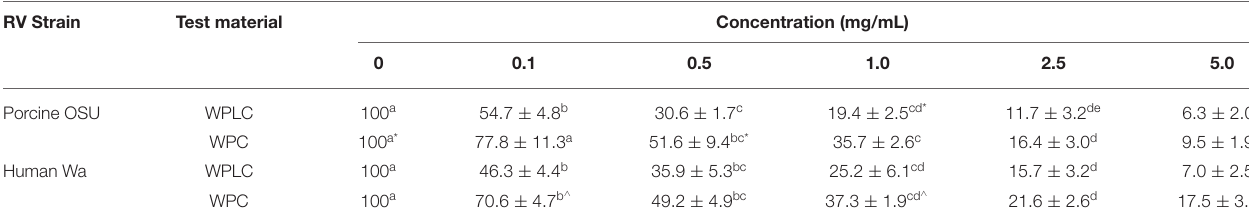
TABLE 2 | Porcine RV OSU and Human RV Wa Infectivity (%) in Caco-2 Cells modulated by co-incubation with either WPLC or WPC. RV